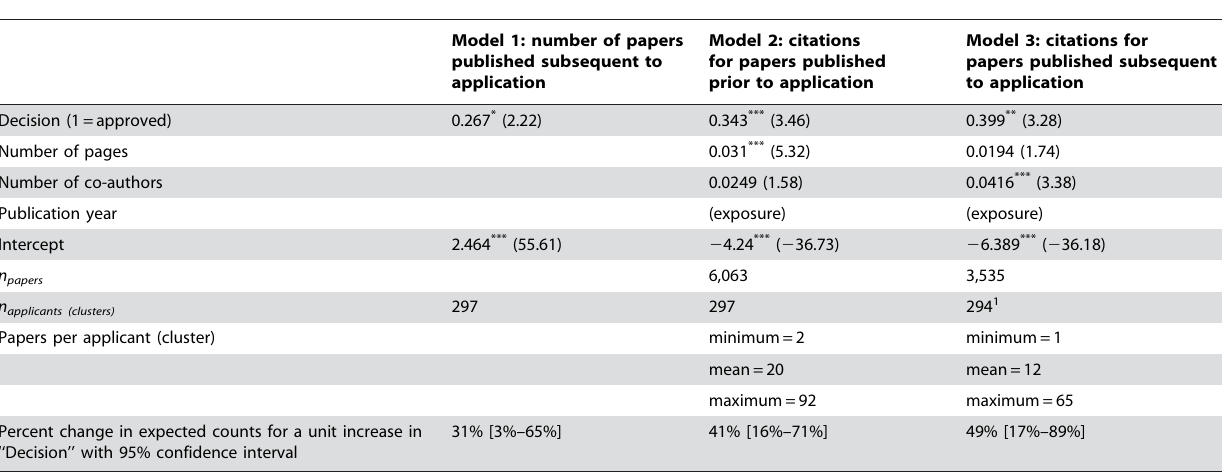
Table 4. (Zero-truncated) negative binomial regression models predicting (1) number of papers published subsequent to application, (2) citations for papers published prior to application and (3) citations for papers published subsequent to application (applicants for the YI